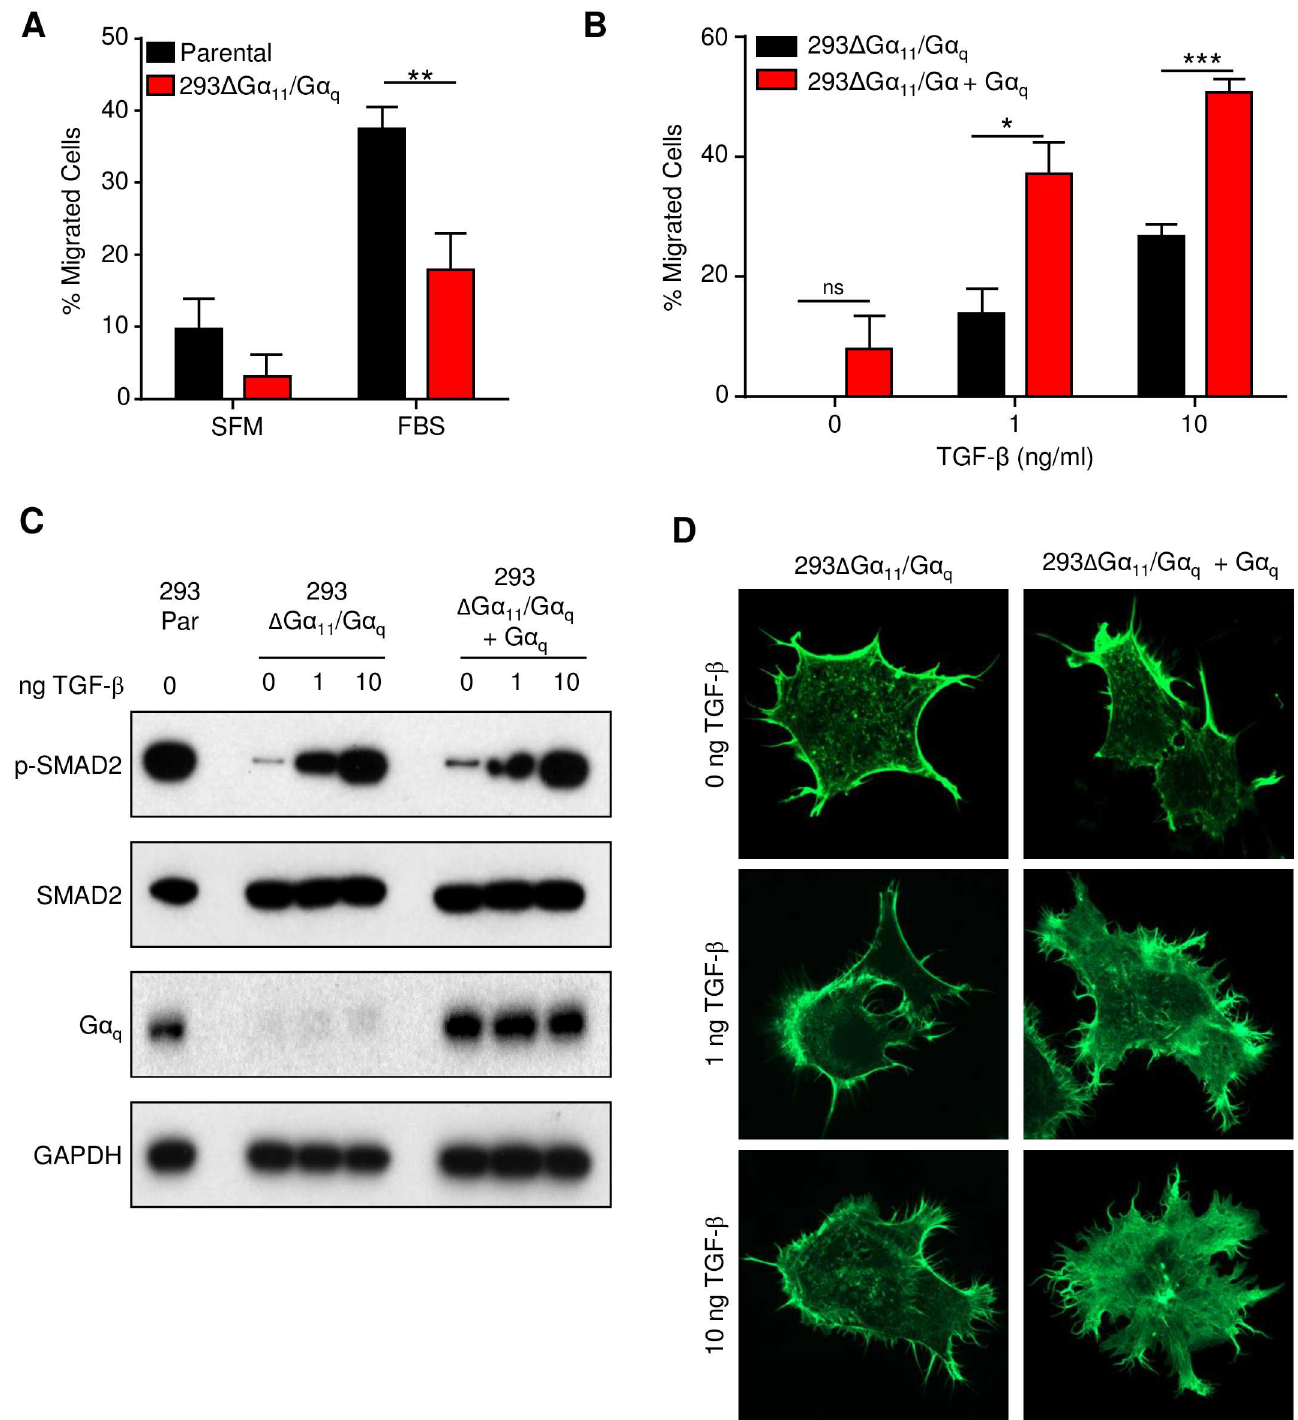
Fig 3. G α q enhances TGF- β stimulated migration and cytoskeletal remodeling. A) Parentaland G α 11/q -null HEK293 cells were assessedfor migrationtowards serum free media (SFM) or 5% fetal bovine serum (FBS). B) G α 11/q -null or G α 11/q -null with transfected,reconstituted expressionof G α q were allowedto migrate towards0, 1, or 10 ng/ml TGF- β 1. C) Western blot demonstrating efficacy of TGF- β signalingin G α 11/q -null and reconstituted cells after 30 minutes treatment with 0, 1, or 10 ng/ml TGF- β 1. D) G α 11/q -null and reconstituted cells co-expressing LifeActGFP were treated with 0, 1, or 10 ng/ml TGF- β 1 for 3 hours and assessed for cytoskeletal changes.Statistical significance was determined by Student’s t-test, * p < 0.05, ** p < 0.01, *** p < 0.001.